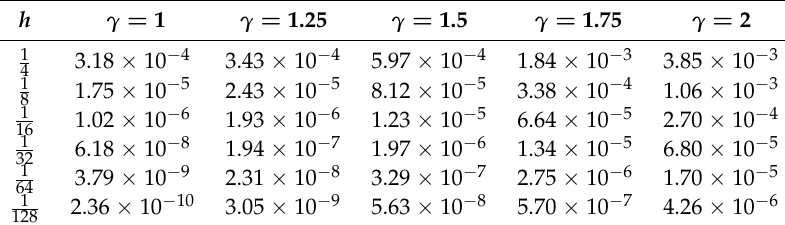
Table 3. The analytical solution, the numerical solution and the approximation error e h evaluated at the collocation nodes are shown in Figure 4 in the case when h = 1/128 . Table 3. Example 2: The infinity norm of the approximation